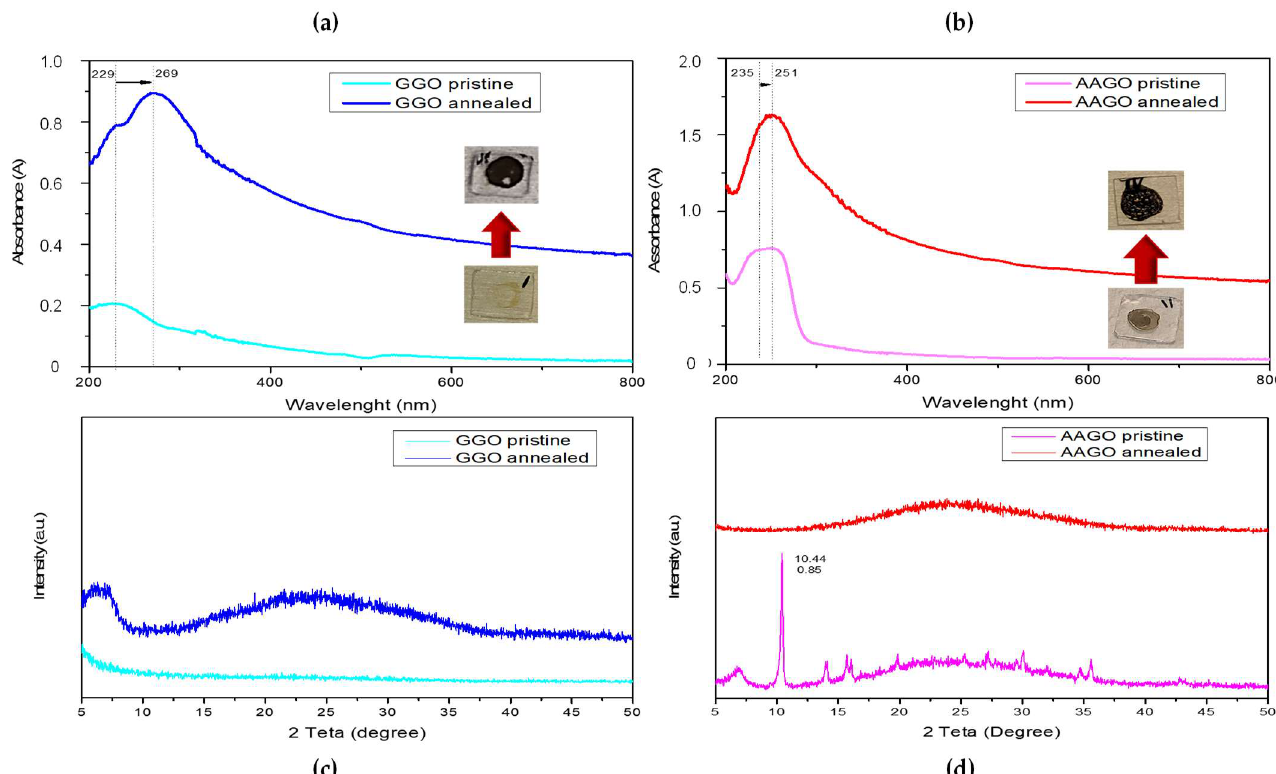
Figure 1. ( a ) UV-Vis absorption spectra of GGO films pre and post-thermal annealing; ( b ) UV-Vis absorption spectra of AAGO films pre and post-thermal annealing; ( c ) XRD patterns of GGO films pre and post-thermal annealing; ( d ) XRD patterns of AAGO films pre and post thermal annealing.